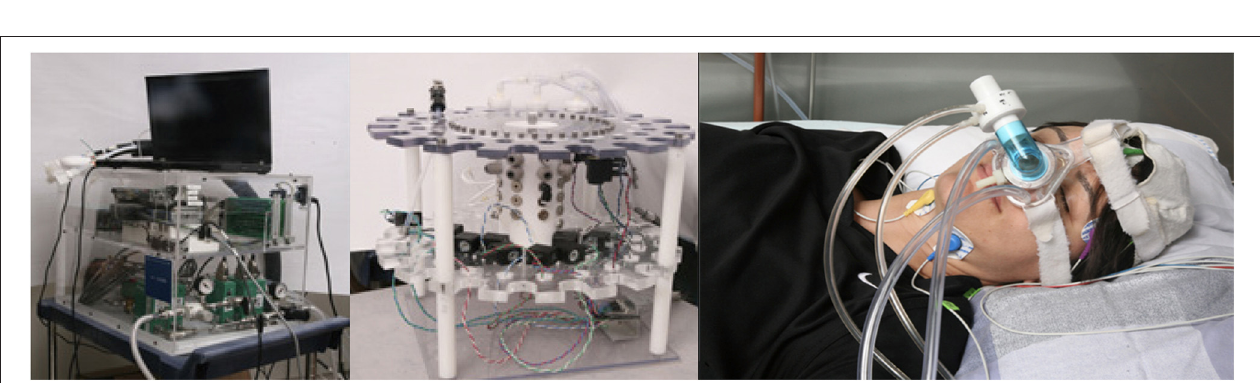
FIGURE 1 | Olfactory proxemics. Ambient : generated in the environment by a source co-located nearby or far away from the user. The distance can range from a personal space to social space or public space (e.g., home diffusers). Wearable : worn by the user in a personal space (e.g., Ezzence wearable). Biological : generated in or on the user in an intimate space (e.g., chemosignals, scent hallucinations, synthetic scents).